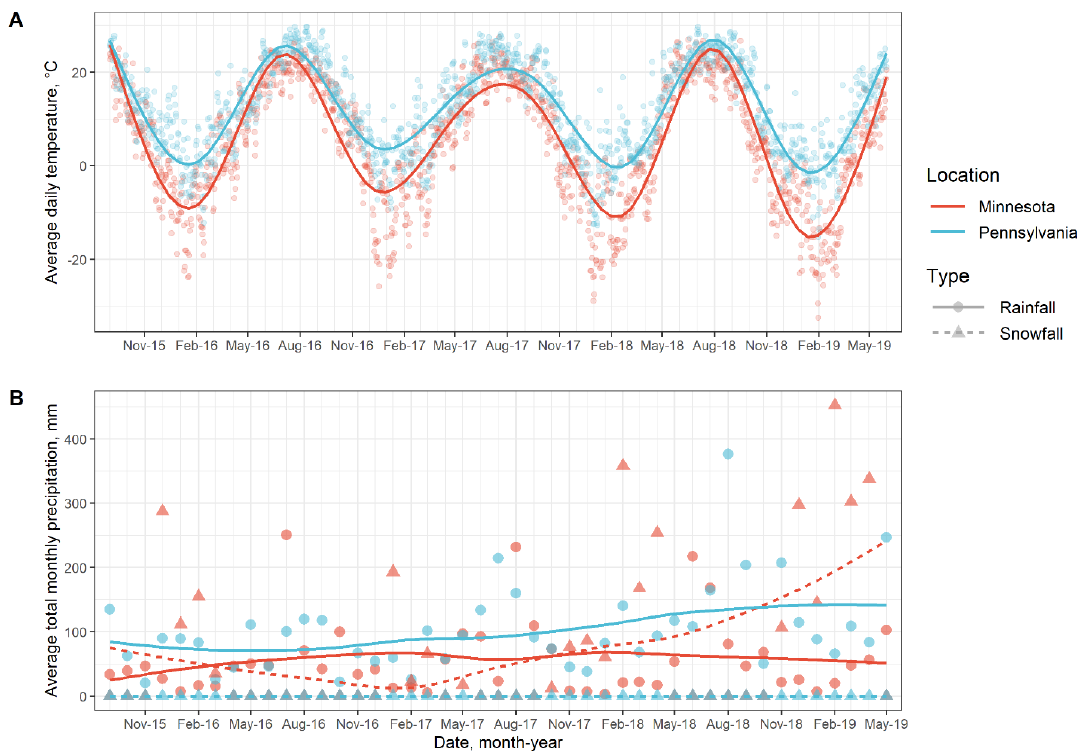
Figure 1. Weather patterns over the course of the study in Minnesota and Pennsylvania.